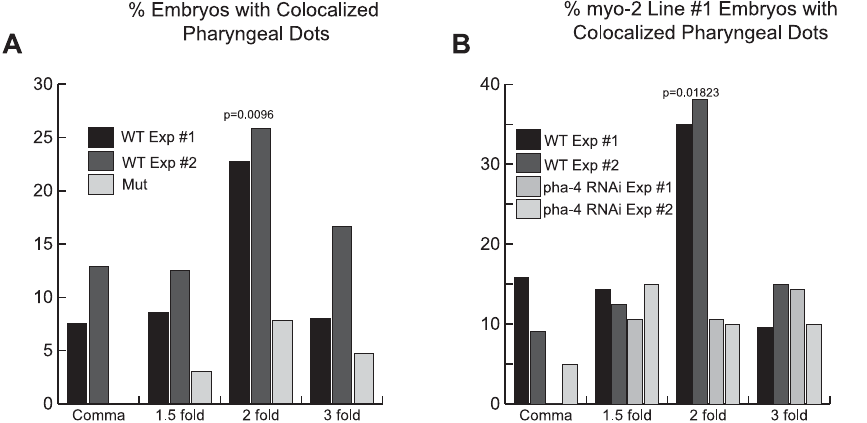
Figure 6. YFP::HTZ-1 Association Peaks at the Onset of myo-2 Expression (A) Association of YFP::HTZ-1 with the myo-2 promoter in the pharynx during the comma, 1.5-, 2-, and 3-fold stages of development (two trials: black, dark grey). YFP::HTZ-1 association in the pharynx does not peak at the 2-fold stage for a myo-2 promoter with both PHA-4 binding sites mutated (Mut, light grey). n . 60 embryos imaged at each stage, for each experiment. Multiple lines were used for each trial. (B) Pharyngeal YFP::HTZ-1 association with myo-2 target array #1 decreased at the 2-fold stage when pha-4 activity was reduced by RNAi . n . 20 embryos imaged at each stage for each of the two wild-type (WT) and two pha-4(RNAi) experiments. The p -values for (A) and (B) indicate the significance of the WT peak at the 2-fold stage as calculated by a repeated measures analysis of variance (ANOVA). DOI: